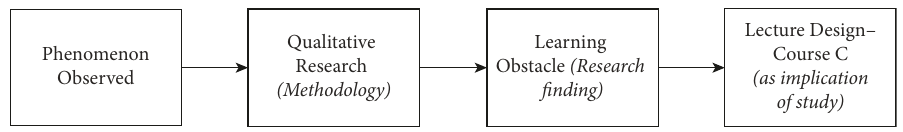
Figure 4: Research